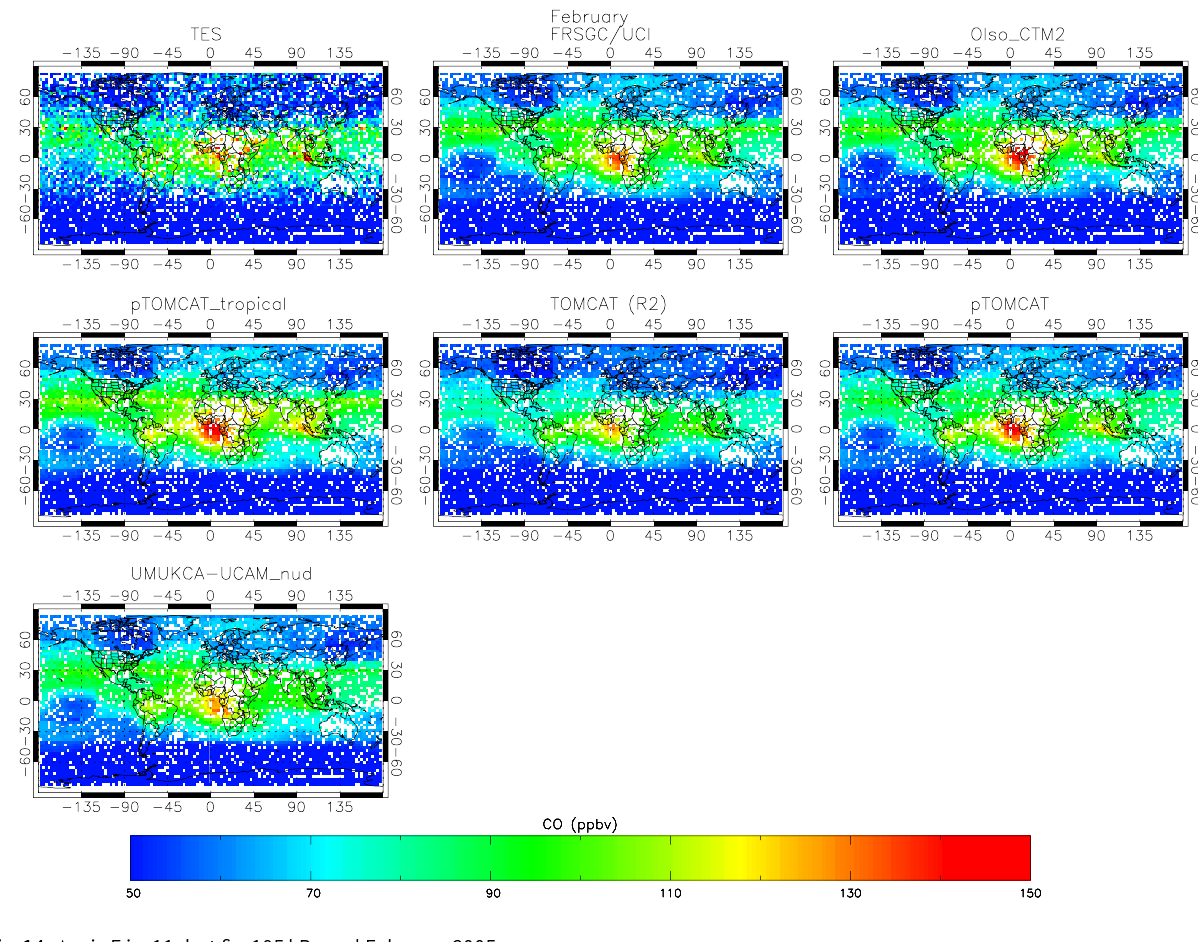
Fig. 14. As in Fig. 11, but for 195hPa and February